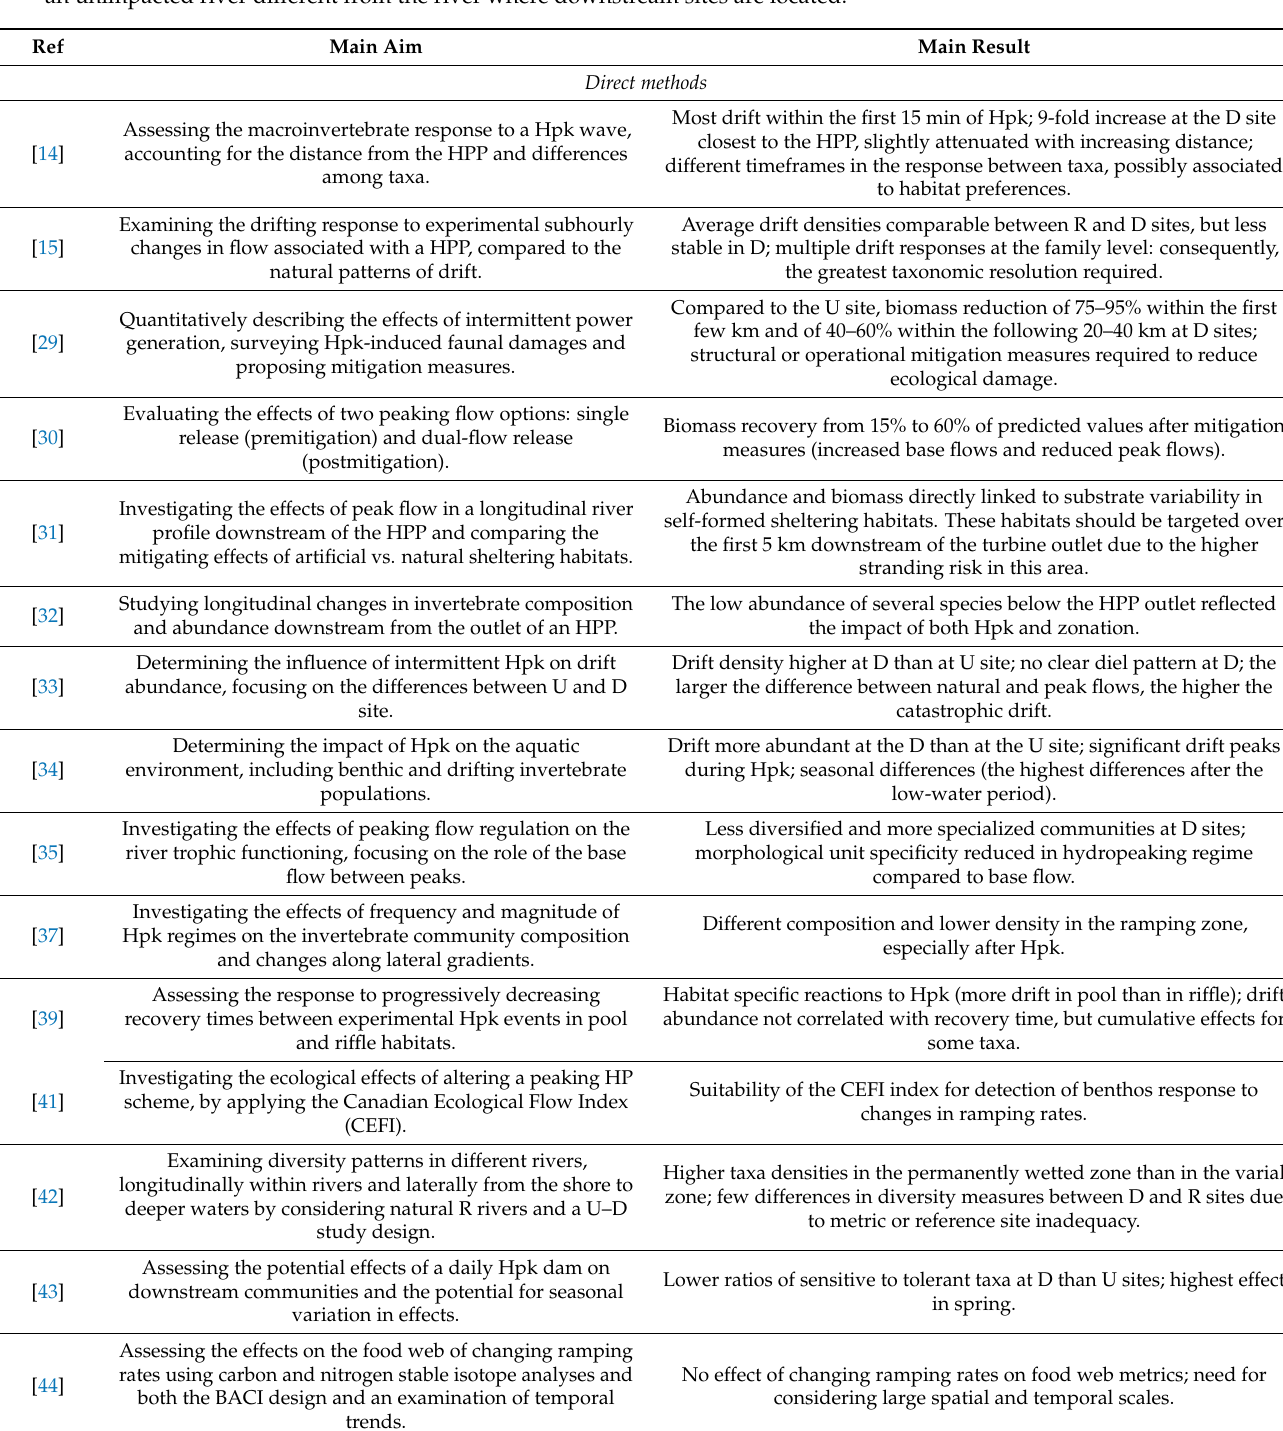
Table 2. Main aim and result of the selected studies, with particular reference to benthic macroinvertebrates. Ref = reference, Hpk = hydropeaking, HPP = hydropower plant, D = downstream site, U = upstream site and R = reference site, i.e., a site in an unimpacted river different from the river where downstream sites are